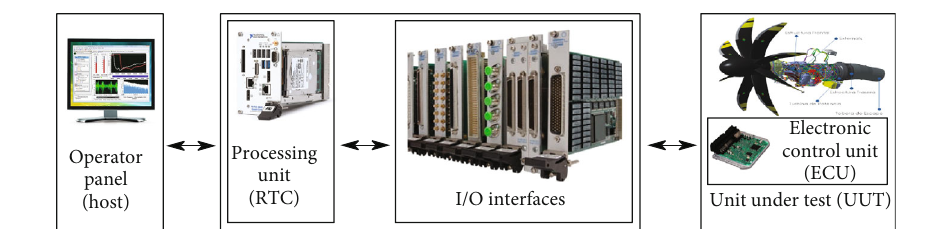
Figure 5: Test equipment.